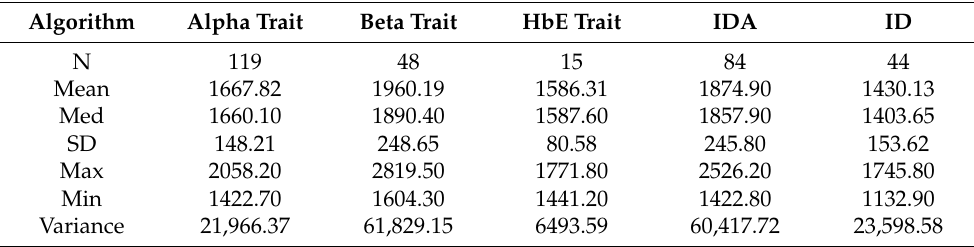
Table 3. In-house validation of the αβ -algorithm to distinguish between various red cell